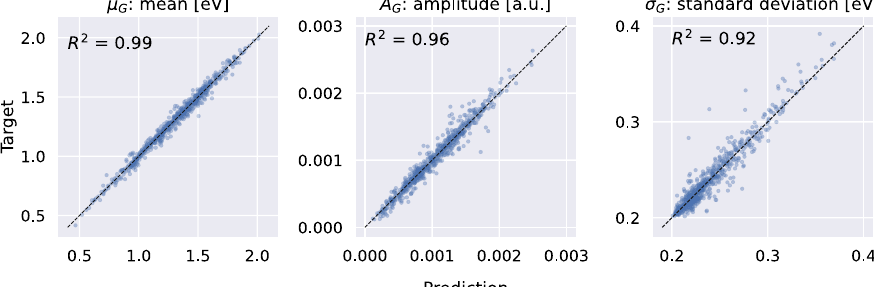
Fig. 5 Parity plots of the ALIGNN-d predictions versus the explicitly computed optical absorption responses of different instantaneous con fi gurations of the Cu(II) aqua complex. The predicted and target Gaussian functions are parameterized by mean μ G , amplitude A G , and standard deviation σ G . The R 2 score (coef fi cient of determination) is provided in each